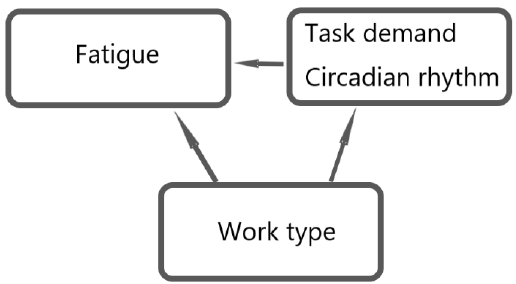
Figure 3. Scheme of the relationship among ATCOs’ fatigue, work type, task demand, and circadian